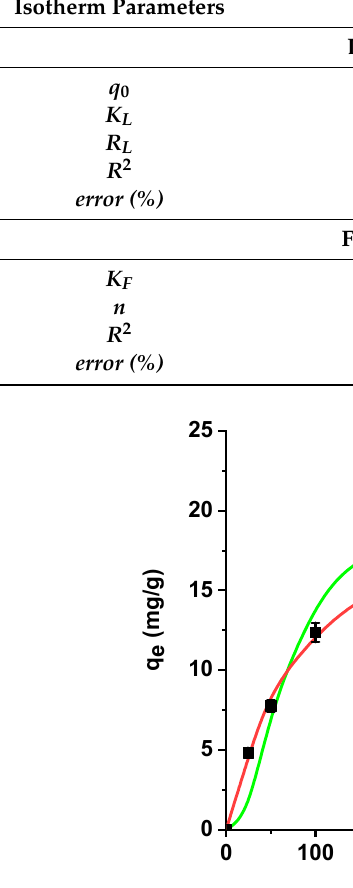
Table 6. The Langmuir and Freundlich parameters for adsorption of arsenic(V) on X np and X np -La(III) (pH 6, shaking speed 180 rpm, temperature 295 K). Isotherm Parameters X np -As(V) X np -La(III)-As(V)